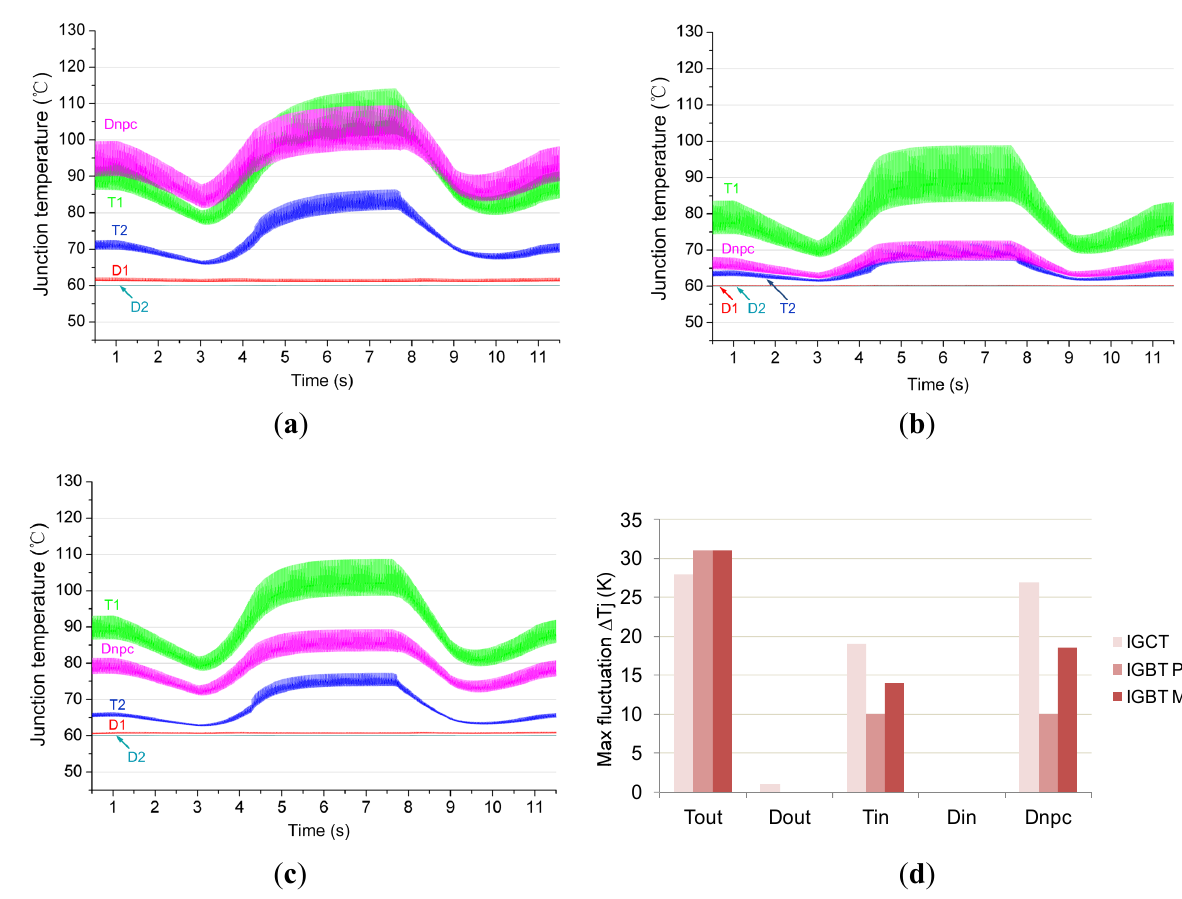
Figure 18. Thermal cycling of the 3L-NPC inverter with different switching device solutions (wind gust operation in Figure 13). ( a ) IGCT presspack solution; ( b ) IGBT